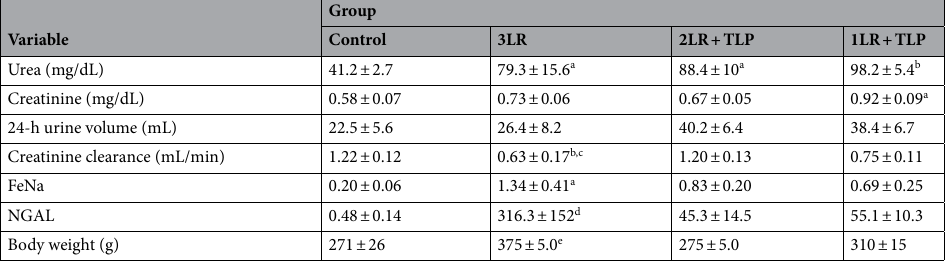
Table 1. Characteristics of the animals at 24 h after the induction of hemorrhagic shock. Control, no intervention; 3LR, induction of hemorrhagic shock, followed by infusion of lactated Ringer’s at 3 times the volume of the blood withdrawn; 2LR + TLP, induction of hemorrhagic shock, followed by infusion of lactated Ringer’s at 2 times the volume of the blood withdrawn, together with intravenous injection of terlipressin at 10 µg/100 g body weight; 1LR + TLP, induction of hemorrhagic shock, followed by infusion of lactated Ringer’s at a volume equal to that of the blood withdrawn, together with intravenous injection of terlipressin at 10 µg/100 g body weight; FeNa, fractional excretion of sodium; NGAL, neutrophil gelatinase-associated lipocalin. a P < 0.05 vs. control; b P < 0.01 vs. control; c P < 0.01 vs. 2LR + TLP; d P < 0.01 vs. control, 2LR + TLP, and 1LR + TLP; e P < 0.05 vs. control, 2LR + TLP, and 1LR +